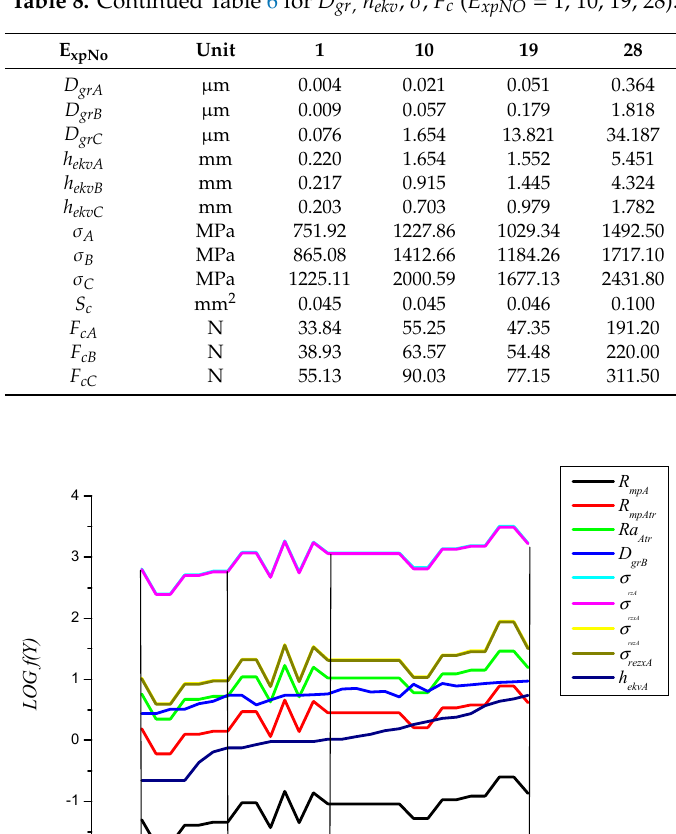
Table 8. Continued Table 6 for D gr , h ekv , σ , F c ( E xpNO = 1, 10, 19, 28).